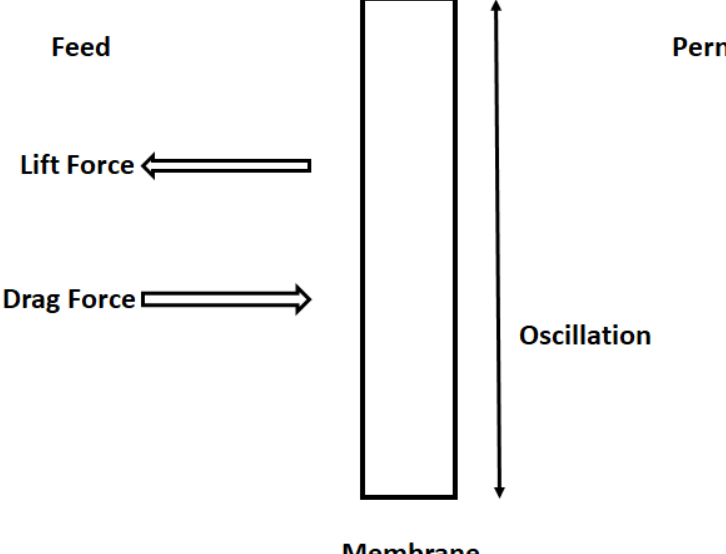
Figure 2. Drag force tries to push the drops to the permeate side, while the lift force coming from the membrane oscillation acts in the opposite direction to the drag force.